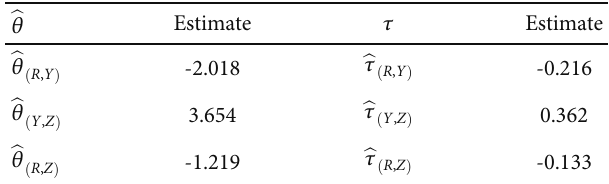
Table 2: Parameters for